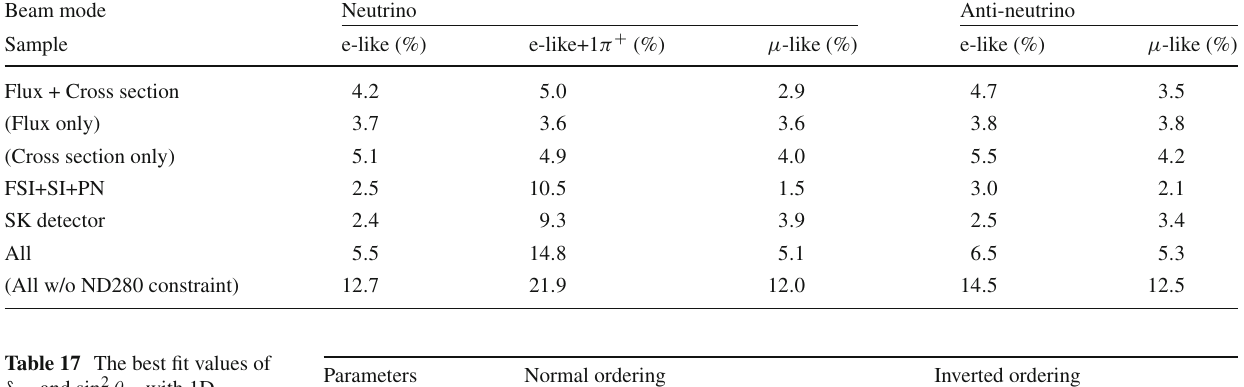
Table 17 The best fit values of δ